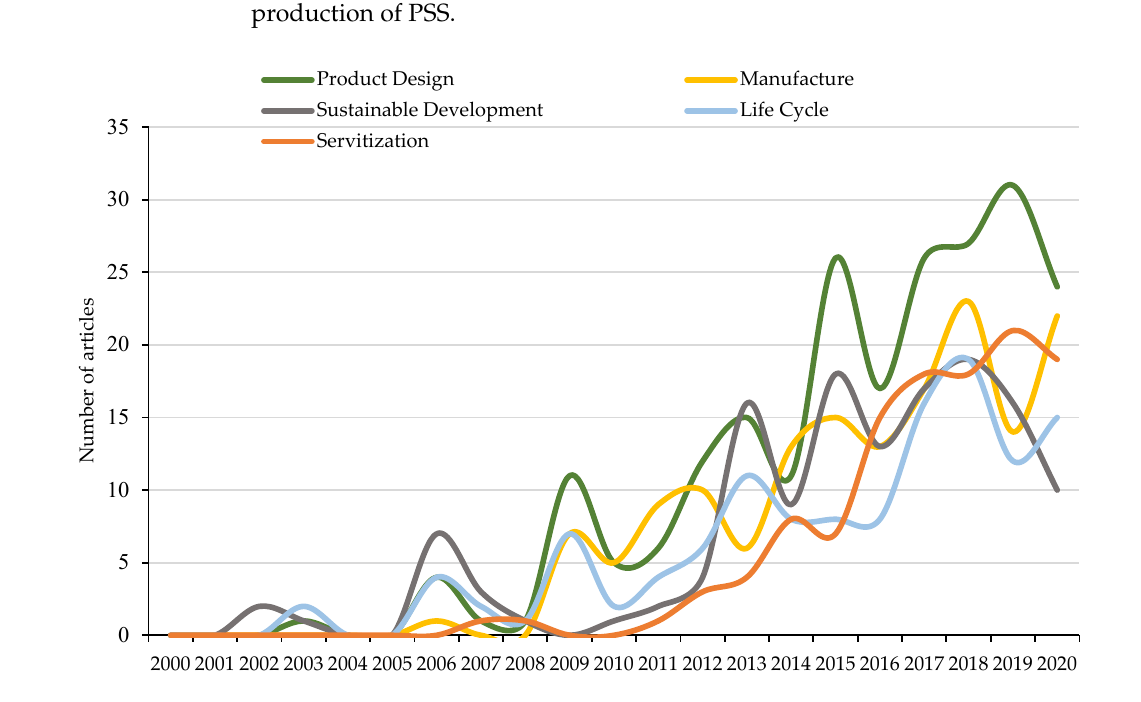
Figure 9. Evolution of the five main keywords.